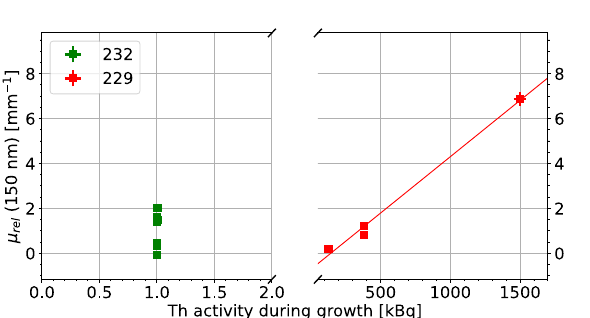
Figure 5. The relative absorption coefficient at 150 nm versus the total activity of Th during growth in the 229 crystal. It can be seen that the absorption of Th doped crystals is dependent on the activity. The absorption 232 232 of Th doped crystals is not determined by the activity. The total activity of Th doped crystals is dominated 229 by the added 1 kBq Th tracer, but is still too low to have any effect. In most cases, the error in activity and absorption is negligible. The red guiding line indicates a correlation between the absorption and the